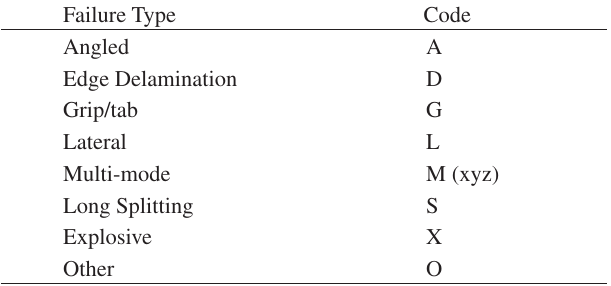
Table 1. Codes related to the first characteristic (“type”) of the failure mode 20 .